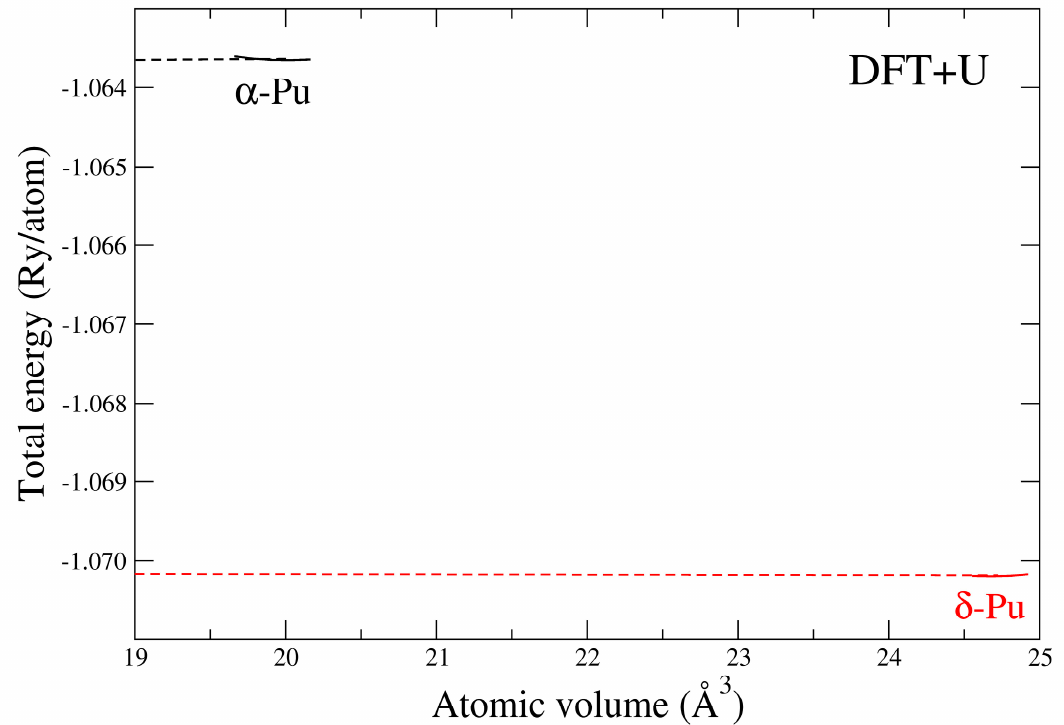
Figure 5. DFT + U (VASP) total energies for α - and δ -plutonium. The calculations include a Hubbard U = 0.4 eV and spin–orbit coupling (not on p states) but no orbital polarization. The dashed lines are guides to the eye only.